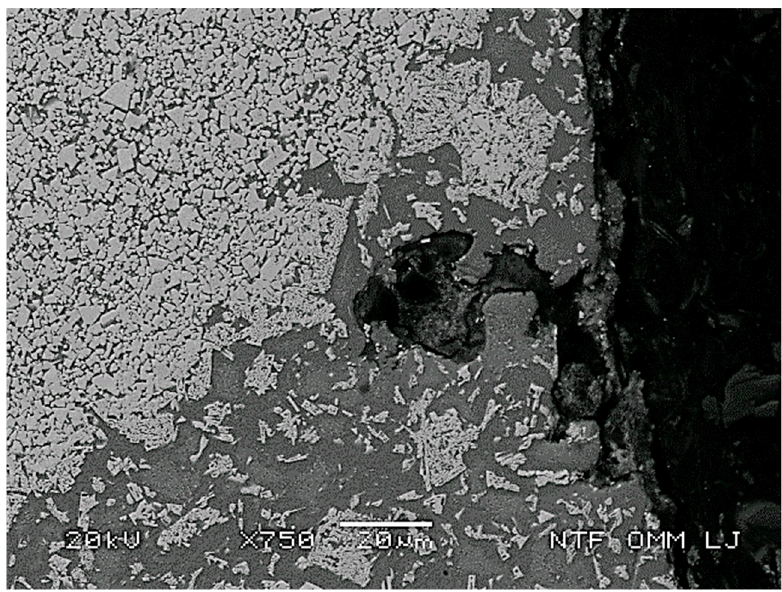
Figure 13. Formation of micro erosion channels in carbide coating matrix.